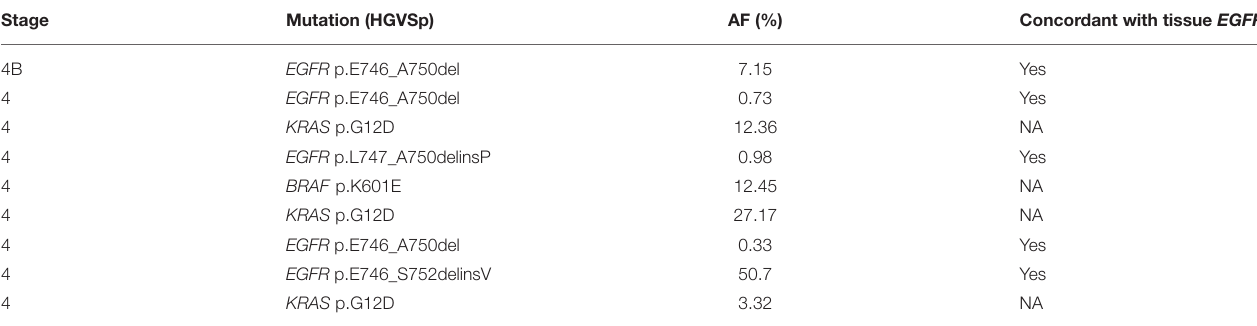
TABLE 6 | Clinically actionable mutations detected in stage 4-4B cases and their concordance of detection with tissue EGFR tests.